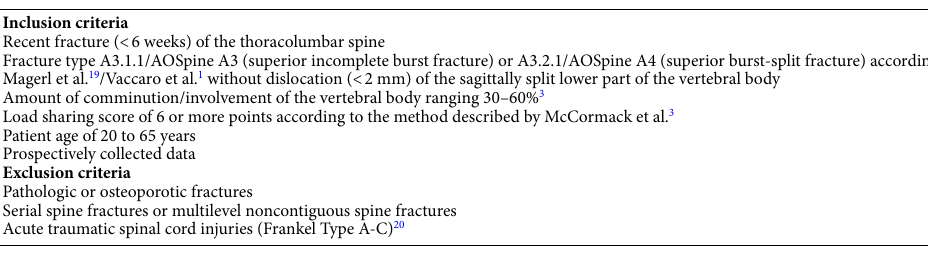
Table 1. Inclusion and exclusion